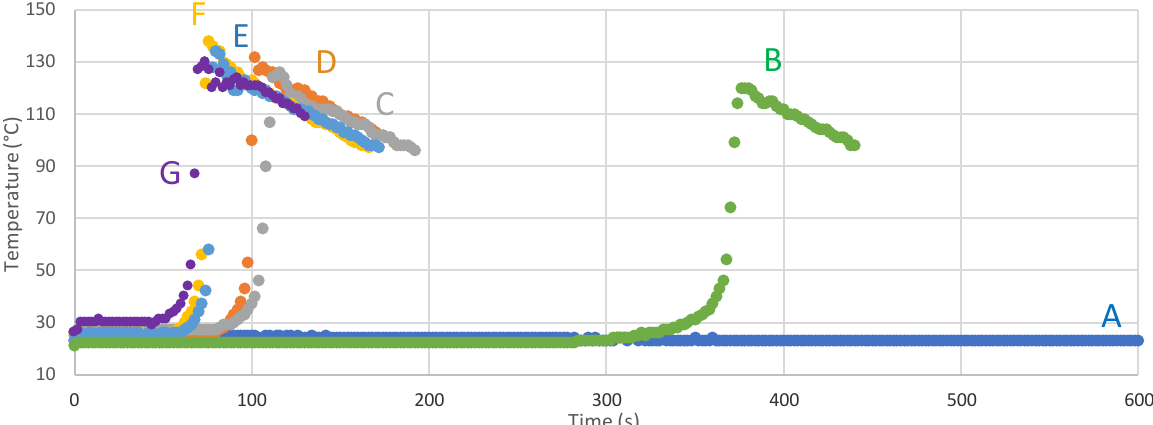
Figure 4. Optical pyrometric measurements (temperature vs. time after mixing; 4 mm thick sample) under air for the BM resin for Redox FRP using different RISs based on T4epa/Iod-Cl (1%/2% w/w ) in presence of different salts: ( A ) without additional salt; ( B ) NaBF 4 (1% w/w ); ( C ) NaSbF 6 (1% w/w ); ( D ) LiTFSI (1% w/w ); ( E ) NaTFSI (1% w/w ); ( F ) NaPF 6 (1% w/w ); ( G ) KTFSI (1% w/w ).